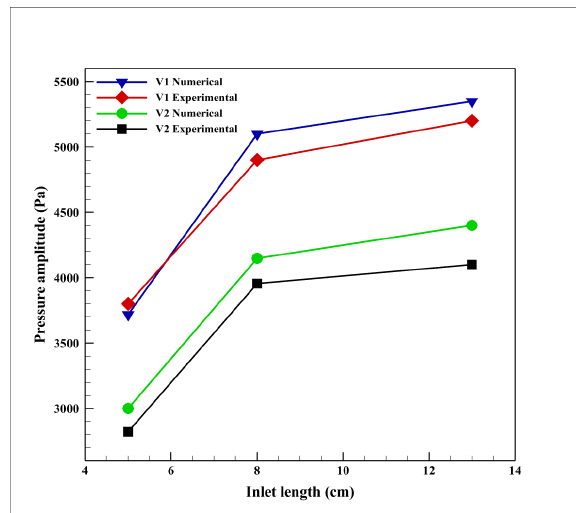
Fig. 7. The variation of pressure amplitude with the inlet pipe length for V1 and